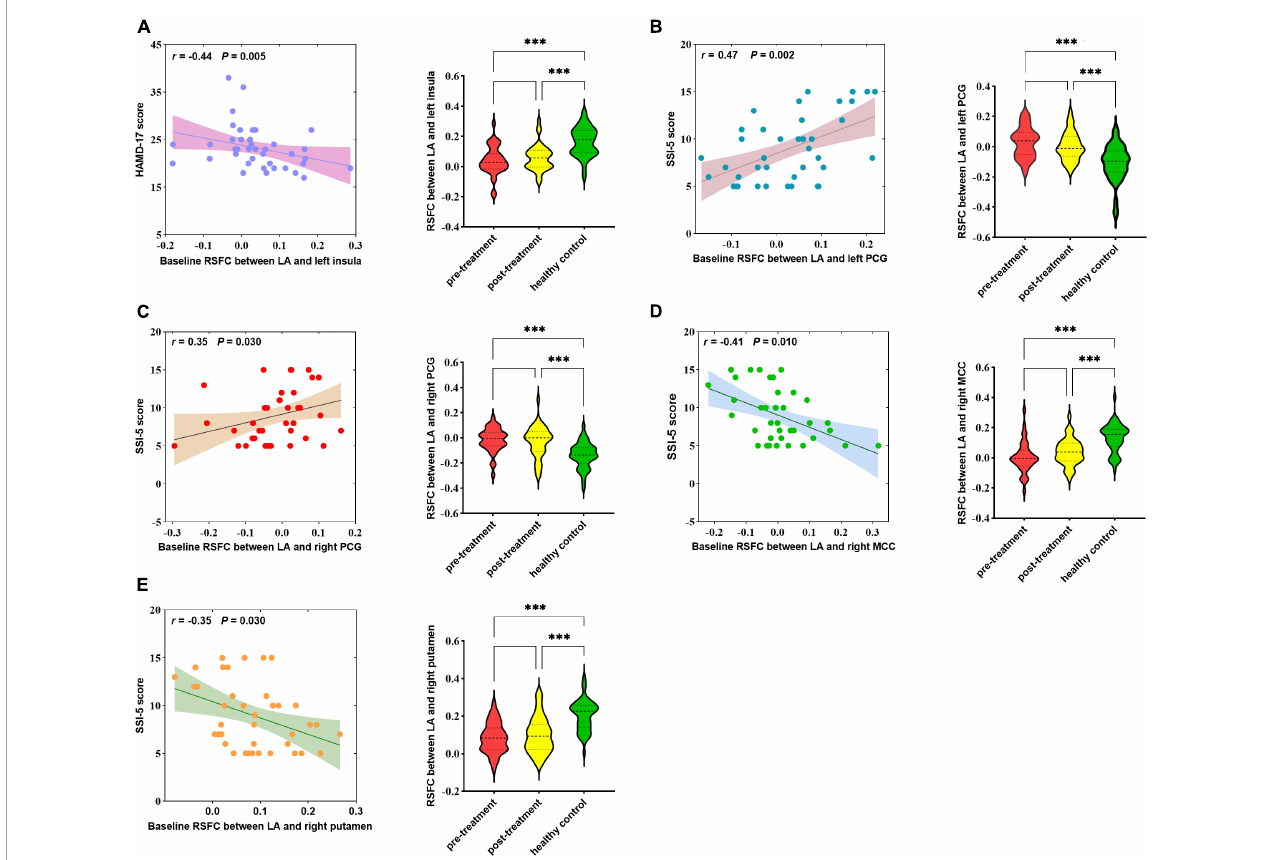
FIGURE2 Correlation between abnormal RSFCs of bilateral amygdala and HAMD-17 score (A) or SSI-5 score (B–E) in MDD patients at baseline. RSFC, resting-state functional connectivity; MDD, Major depressive disorder; HCs, healthy controls; LA, left amygdala; PCG, posterior central gyrus; MCC, mid-cingulate cortex; MOG, middle occipital gyrus. ∗∗∗ P < 0.001.